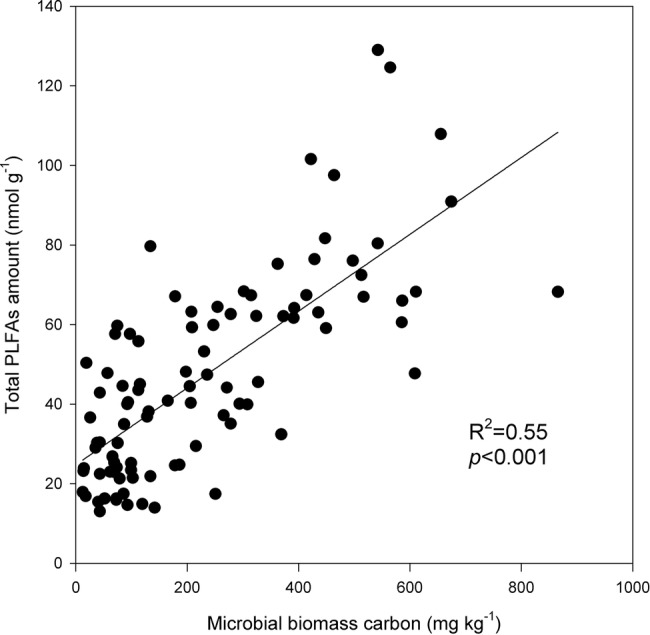
Linear relationship between the total amounts of phospholipid fatty acids (PLFAs) and soil microbial biomass carbon. The plots are observation values, and the solid line is the linear regression line. The coefficient of determination R2 and significance level p are presented.